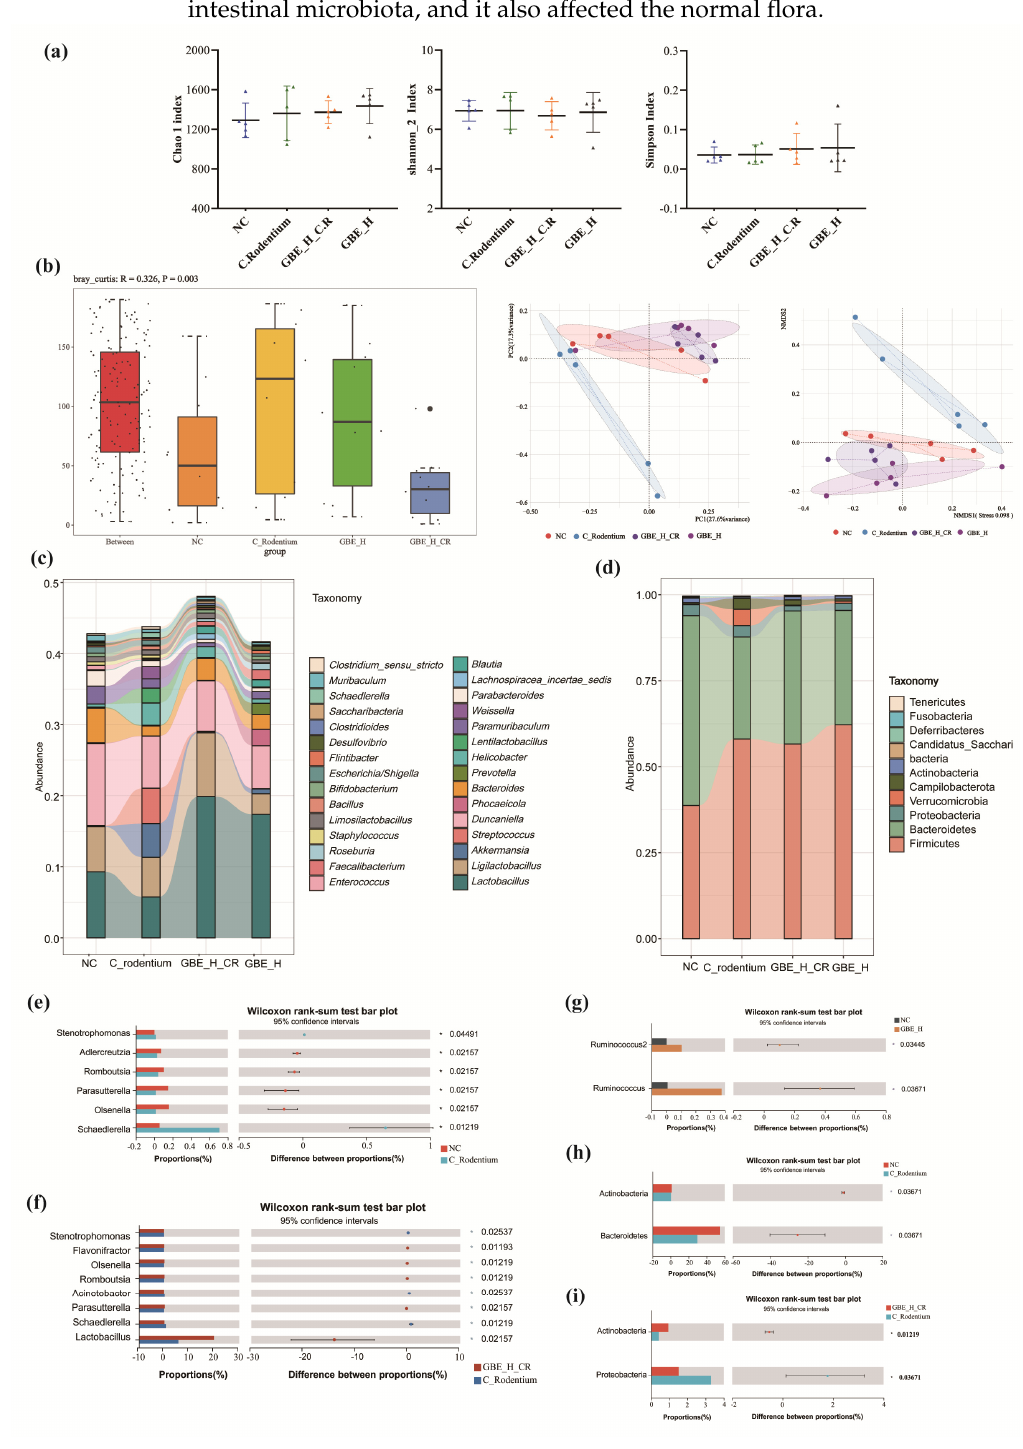
Figure 6. GBE modulated gut microbiota. ( a ) α diversity represented by the Chao 1, Shannon_2, and Simpson indices. ( b ) β diversity under Anosim, NDMS, and PCoA analysis. Taxonomic distributions regarding gut microbial compositions at the genus ( c ) and phylum ( d ) levels. Wilcoxon rank-sum test for the NC and C. Rodentium groups at the genus level ( e ), the GBE_H_CR and C. Rodentium groups at the genus level ( f ), the NC and GBE_H groups at the phylum level ( g ), the NC and C. Rodentium groups at the phylum level ( h ), and the GBE_H_CR and C. Rodentium groups at the phylum level ( i